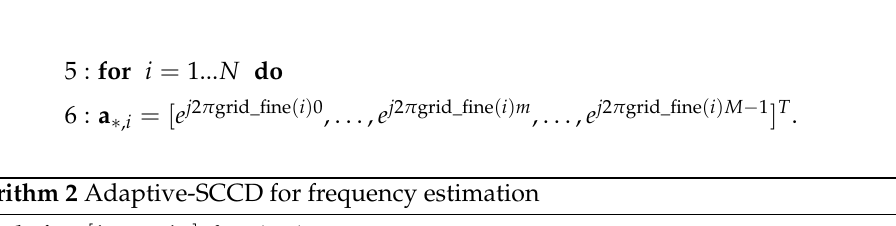
Algorithm 2 Adaptive-SCCD for frequency estimation